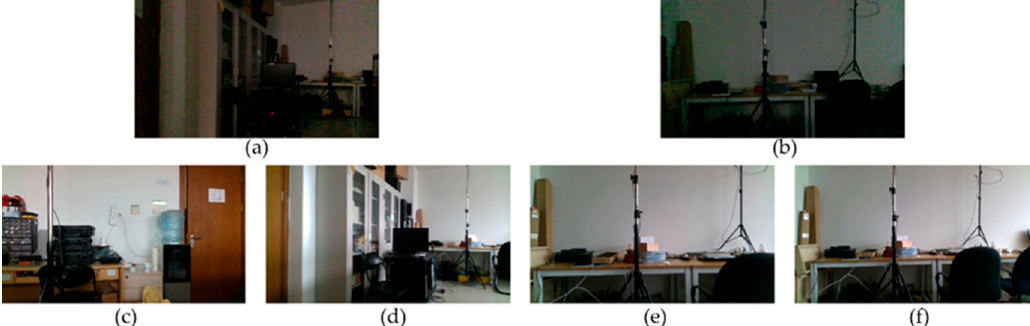
Figure 6. Query images in office scene and query results: ( a ) Query image no. 1; ( b ) query image no. 2; ( c ) query result of image 1 with the VLAD method; ( d ) query result of image 1 with our proposed method; ( e ) query result of image 2 with the VLAD method; ( f ) query result of image 2 with our proposed method.